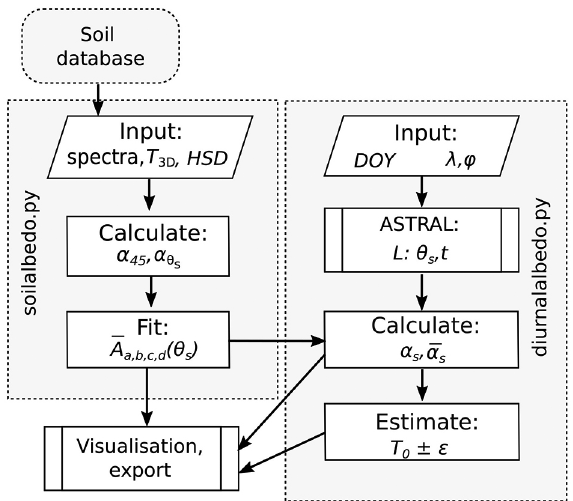
Fig. 3. Scheme of calculation implemented in SALBEC. For symbol explanation, see text. SALBEC, Soil ALBEdo Calculator.